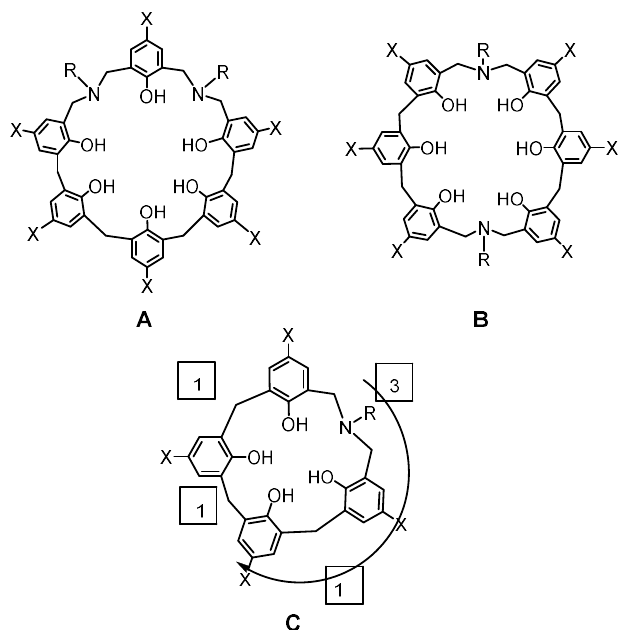
Figure 2. Nomenclature rule of azacalixarenes.